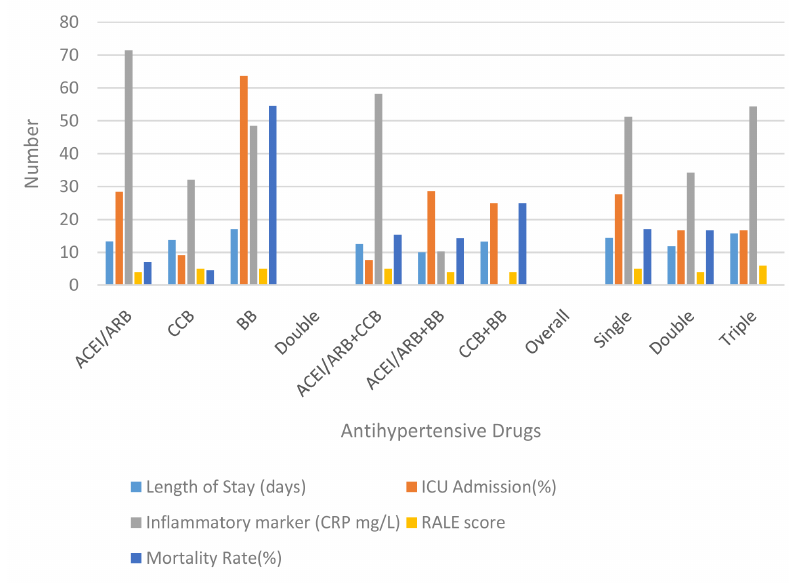
Figure 2. Comparison between group anti-hypertensive drugs. ACEI/ARB: angiotensin-converting enzyme inhibitors and angiotensin receptor blockers; CCB: calcium channel blocker; BB: beta blocker; ICU: intensive care unit; RALE: radiographic assessment of lung edema.